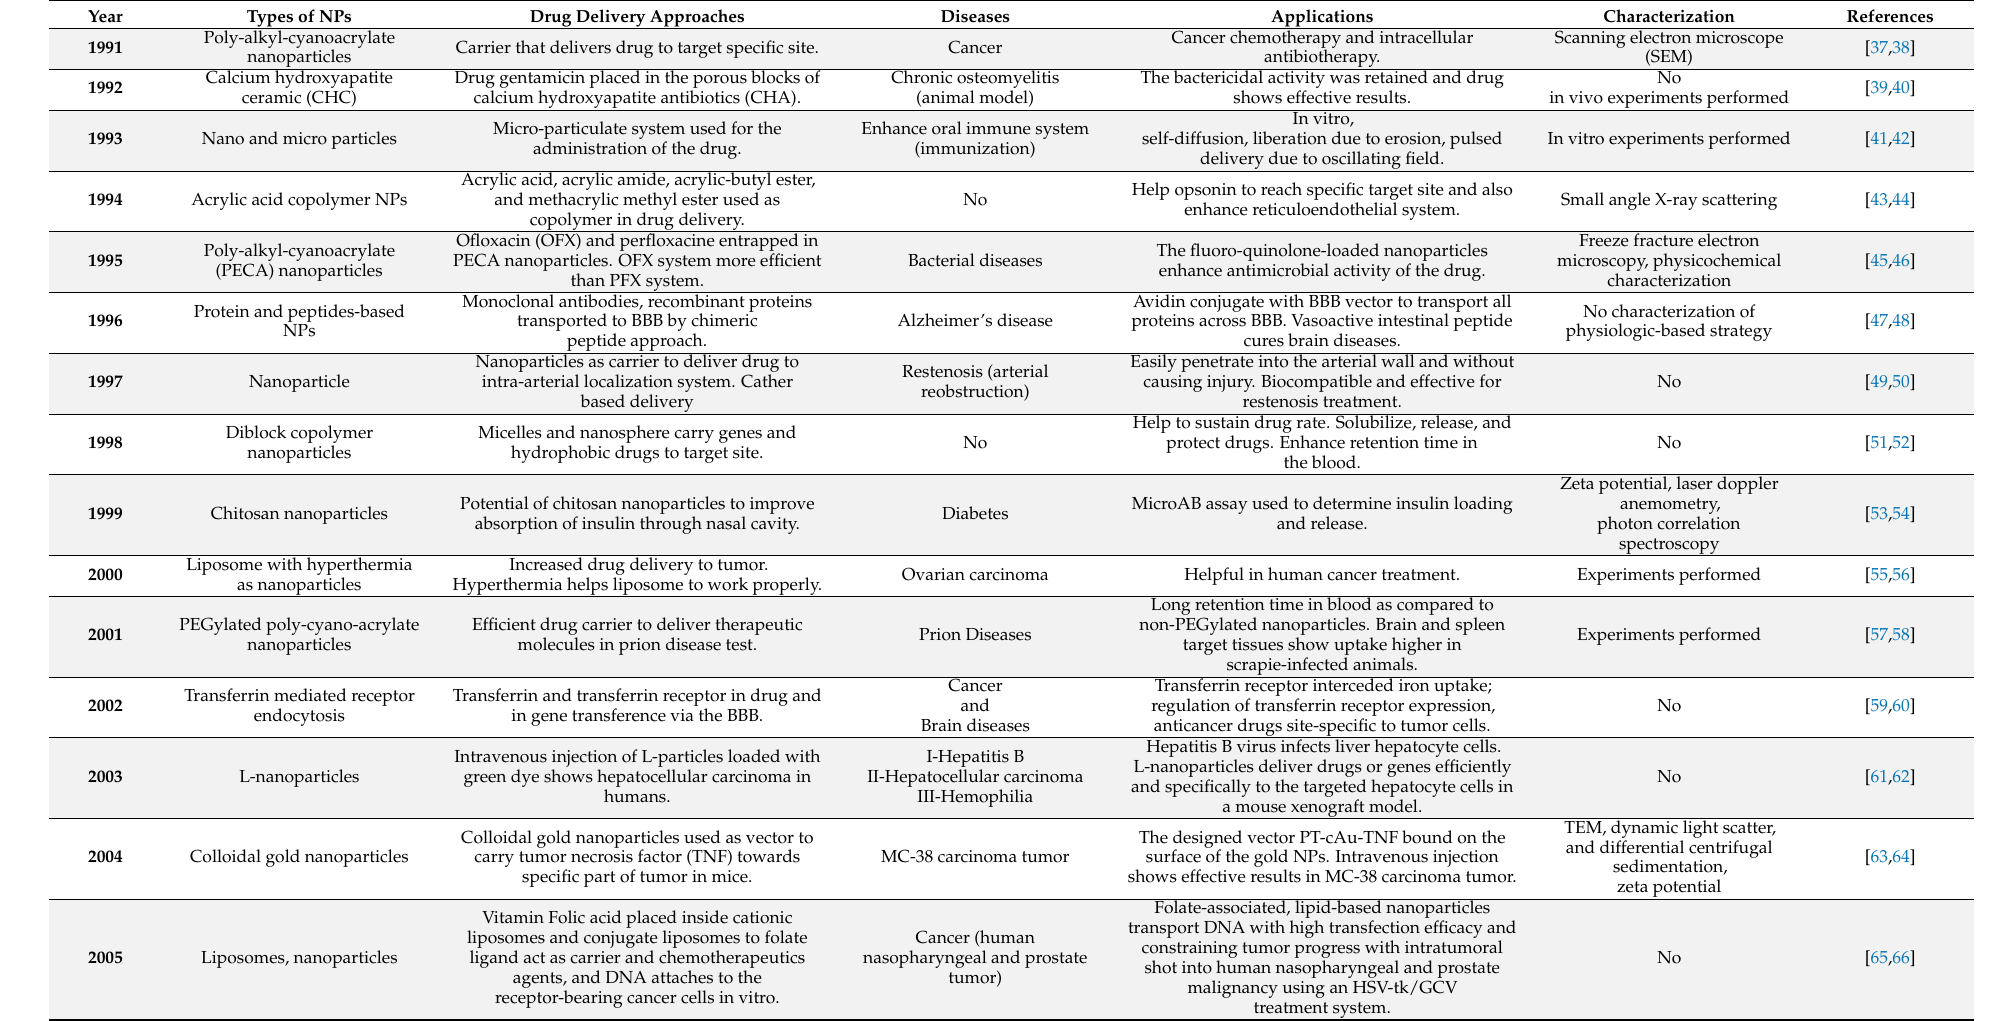
Table 1. Evolution of nanoparticles from 1991 to 2022 in detail discussed here.